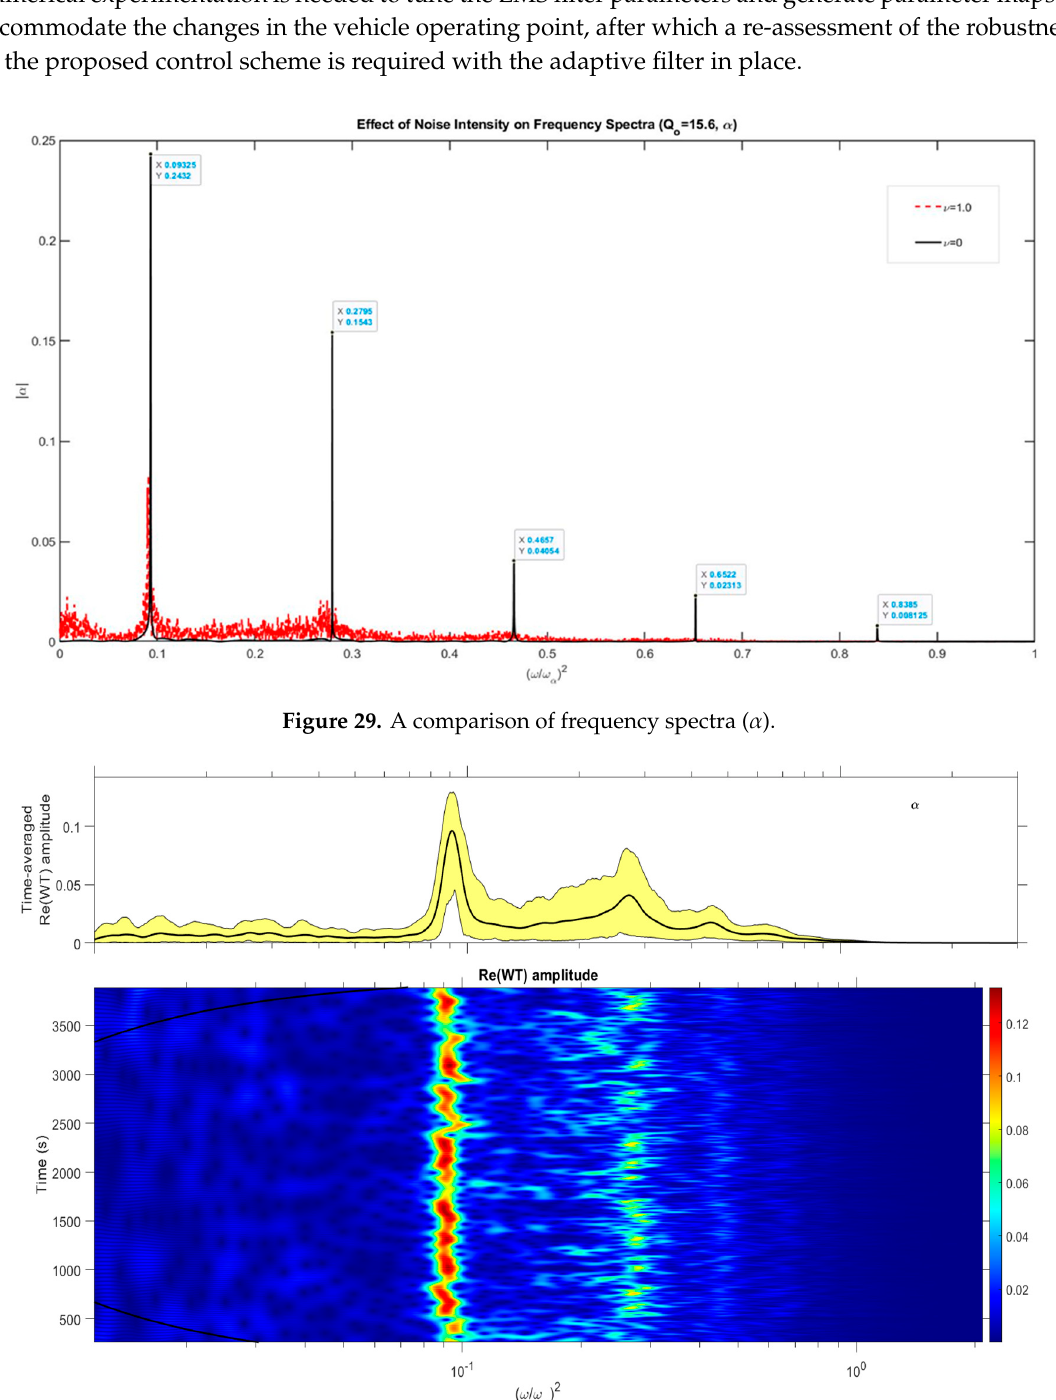
Figure 30. Time–frequency analysis ( 𝛼 , open-loop, ν = 1 ).